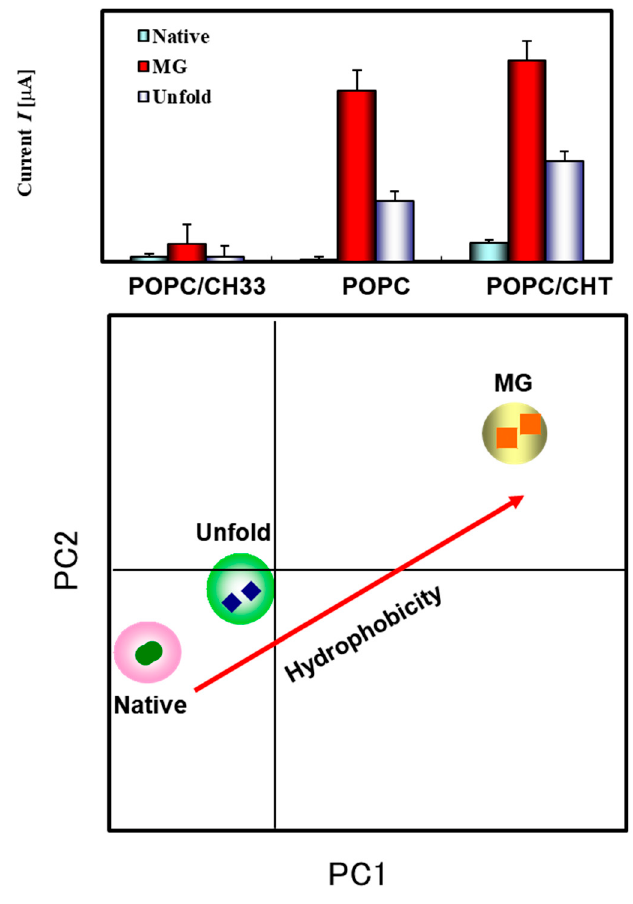
Figure 6. Results of principle of component analysis as pattern recognition technique applied to response patterns using the electrical current signal from proteins structural conditions (native, MG and unfold states) and three types of ILE (POPC, POPC/CHT and POPC/CH33). The used proteins are CAB and lysozyme.